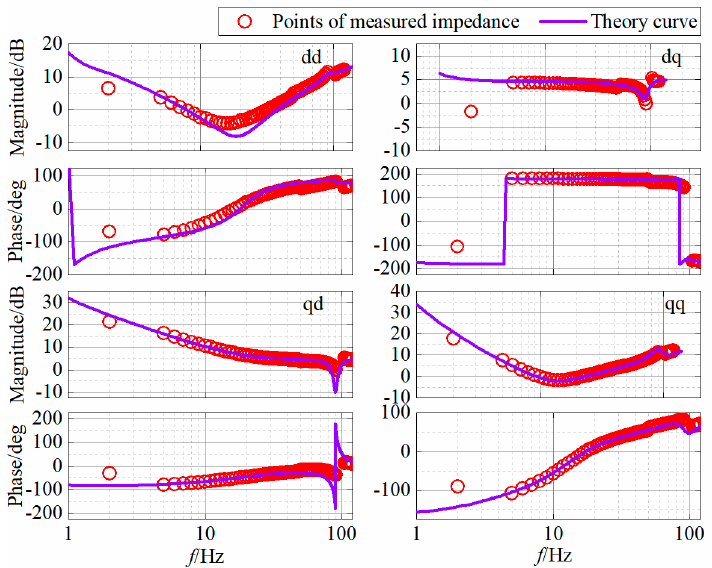
Figure 6. Comparison between the theoretical curve of dq impedance and measurement points of CRH5.